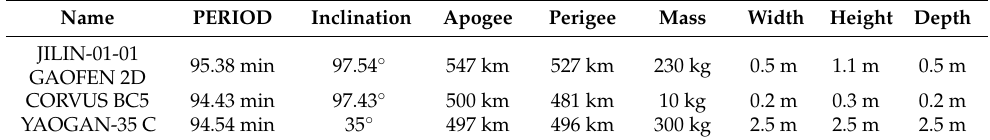
Table 3. Satellite